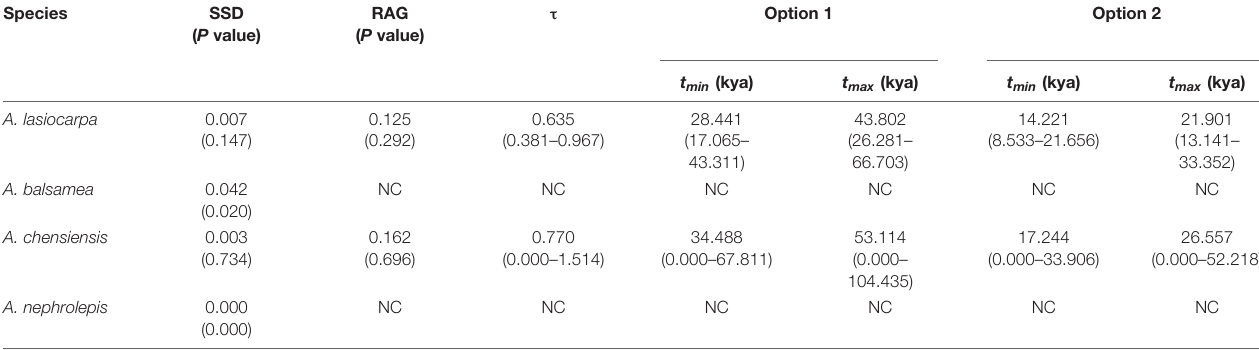
TABLE 3 | The results of mismatch distribution analysis based on cpDNA sequence. Species